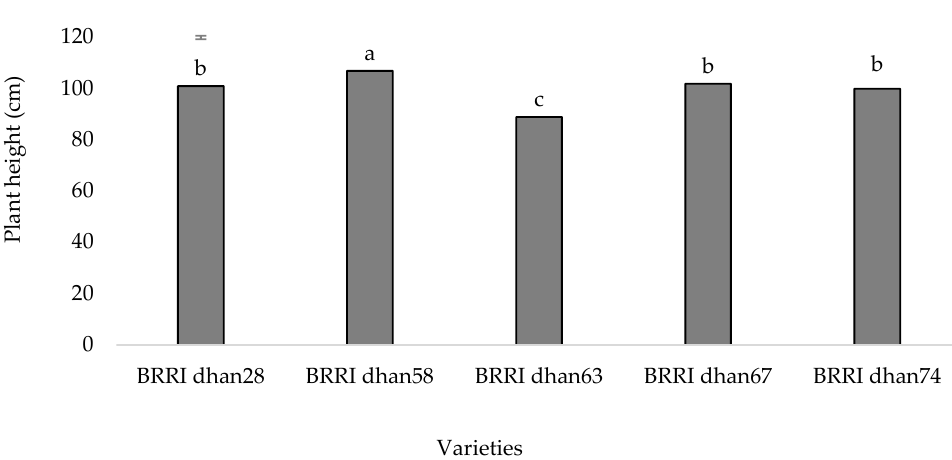
Figure 5. Effect of rice varieties on the plant height. The means with similar letters do not differ